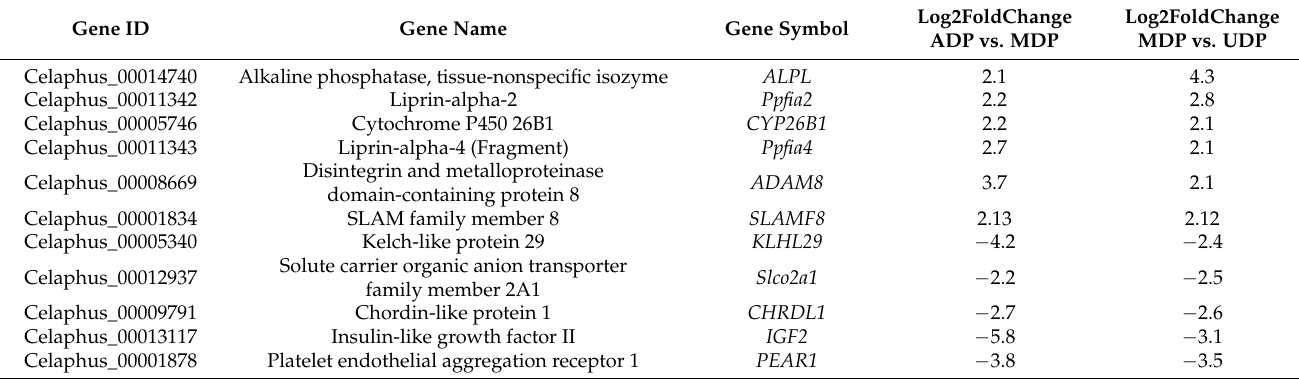
Table 1. The 11 co-expressed DEGs † in UDP, MDP, and ADP ‡ , including six gradually up-regulated genes and